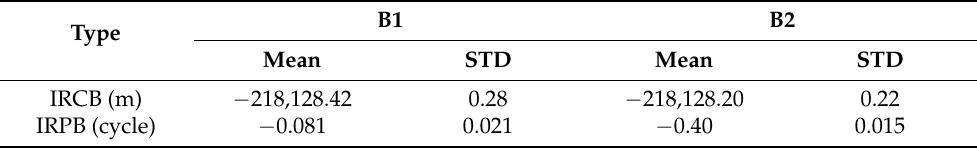
Figure 8. The sky-plot of r 1 and r 2 . Various colors denote different satellite tracking situations in the simulation, respectively. The light blue area denotes that the satellite signal tracked by r 1 and the yellow represents tracked signals for r 2 , respectively. Table 4. IRB statistics under the common clock